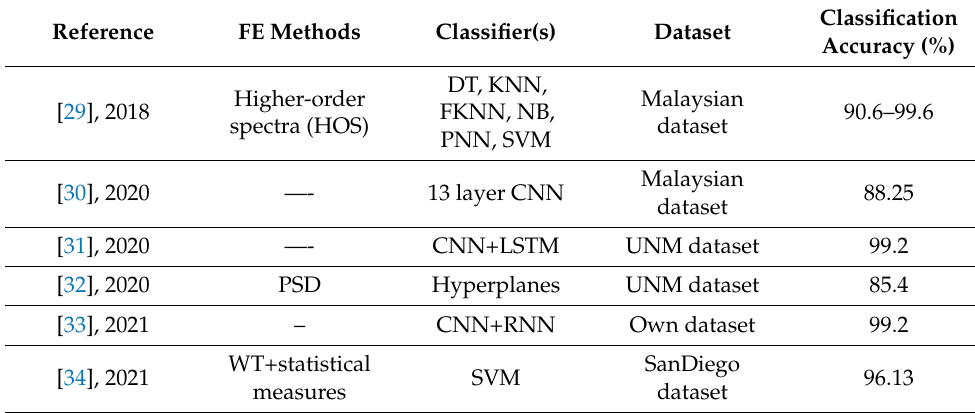
Table 1. Summaries of methods of previous studies and their